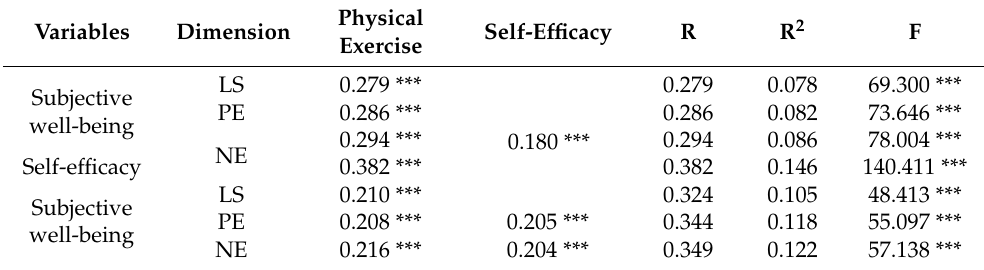
Table 4. Regression analysis between the sub-dimensions of physical exercise, self-efficacy, and subjective